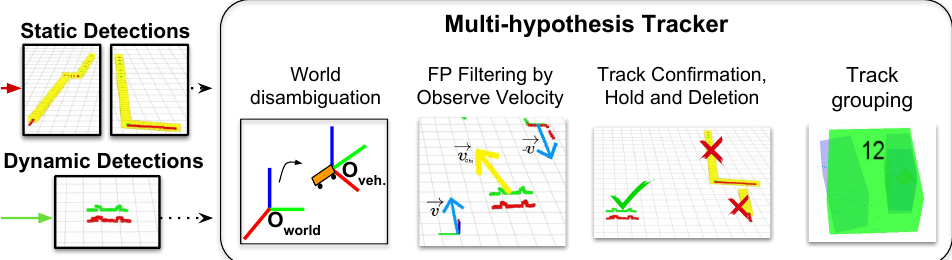
Figure 7. Modules included in our MH-Tracker system. Our tracker works in local coordinates from the ego vehicle, so an initial coordinate transformation is performed to the dynamic detections. In this local frame, we filter false positively detected dynamic objects attending to their observed velocity. We further introduce our track confirmation, hold and deletion functions as well as our track grouping, which is based both on object spatial location and target velocities. Best viewed in